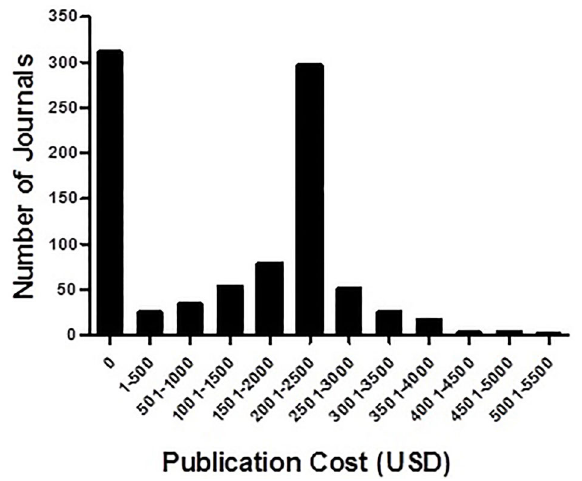
Figure 2. Price distribution for open access journals. Data were collected from online price lists for journals managed by Elsevier, Nature Publishing Group, Wiley, BioMed Central, and the Public Library of